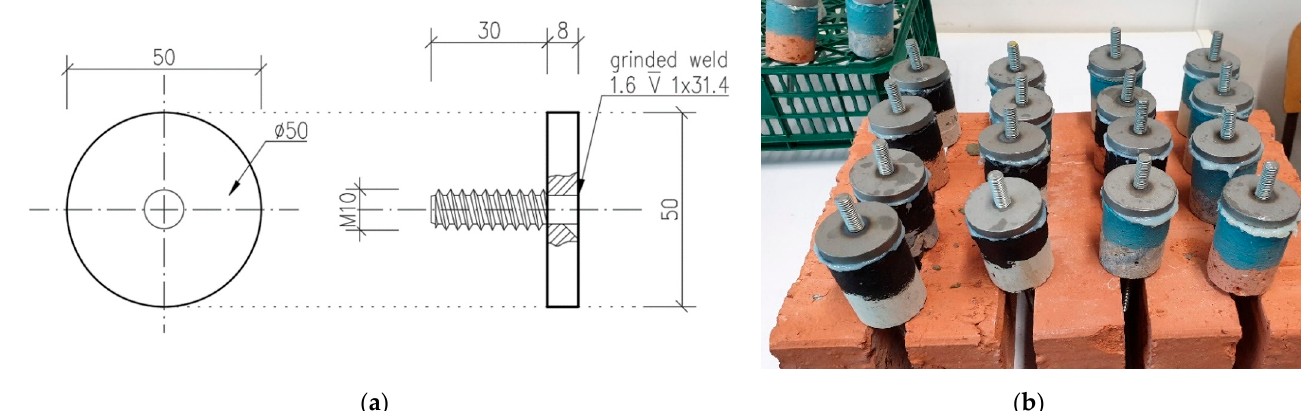
Figure 8. ( a ) Tear-off test disc target scheme; ( b ) gluing tear-off targets. During the tear-off tests, it was necessary to ensure the axial loading. The tension was exerted by a steel ring which is screwed onto the threaded rod. A similar fastening system was used on the opposite side (Figures 9 and 10).